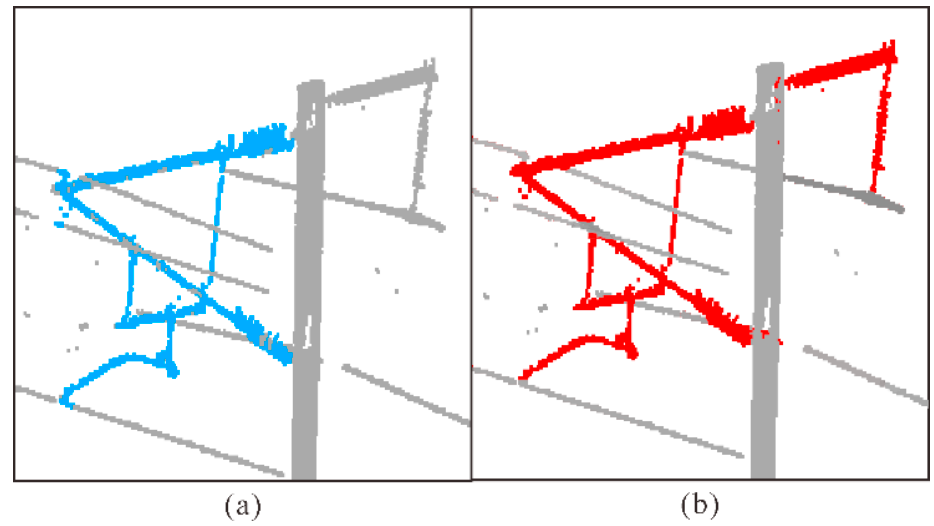
Figure 15. Different extraction effects of the integrated PF, RC, and VPF filters and integrated PF and VPF filters. Specifically, ( a ) is the extraction of the integrated PF, RC, and VPF and ( b ) is the extraction of the integrated PF and VPF.